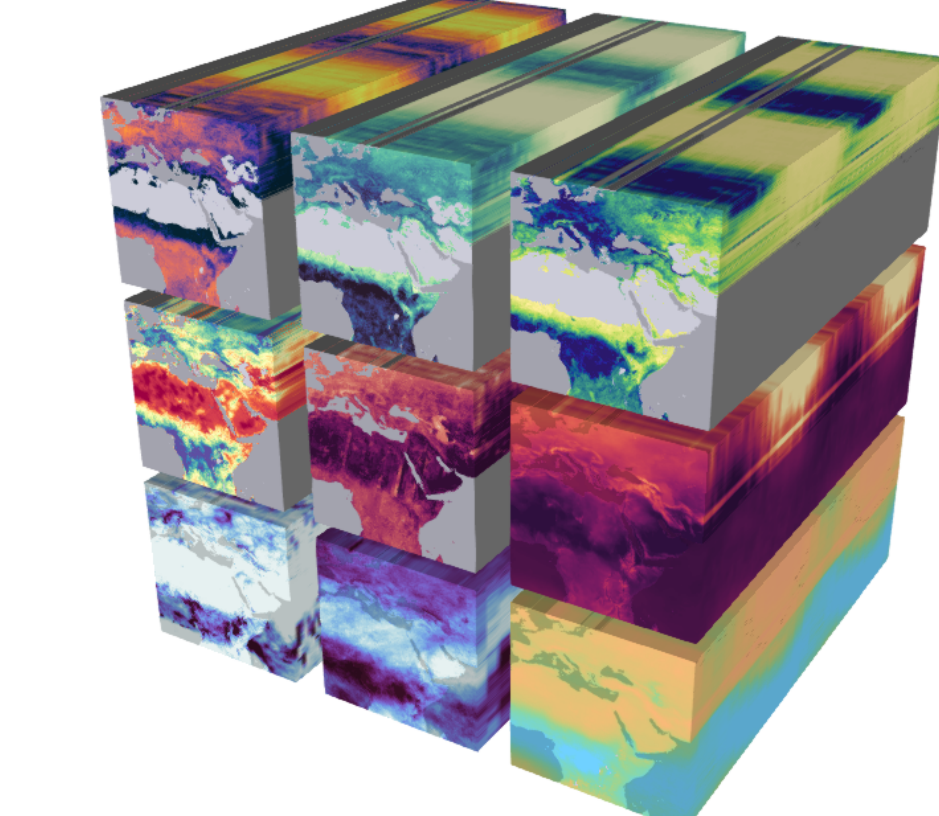
Figure 3. Visualization of the implemented Earth system data cube (an animation is provided online at https://youtu.be/9L4-fq48Ev0, last access: 21 February 2020). The figure shows from the top left to bottom right the variables sensible heat ( H ), latent heat ( LE ), gross primary production (GPP), surface moisture (SM), land surface temperature (LST), air temperature ( T air ), cloudiness ( C ), precipitation ( P ), and water vapour ( V ). References to the individual data sources are given in Appendix A. Here, the resolution in space is 0.25 ◦ and 8d in time, and we are inspecting the time from May 2008 to May 2010; the spatial range is from 15 ◦ S to 60 ◦ N, and 10 ◦ E to 65 ◦